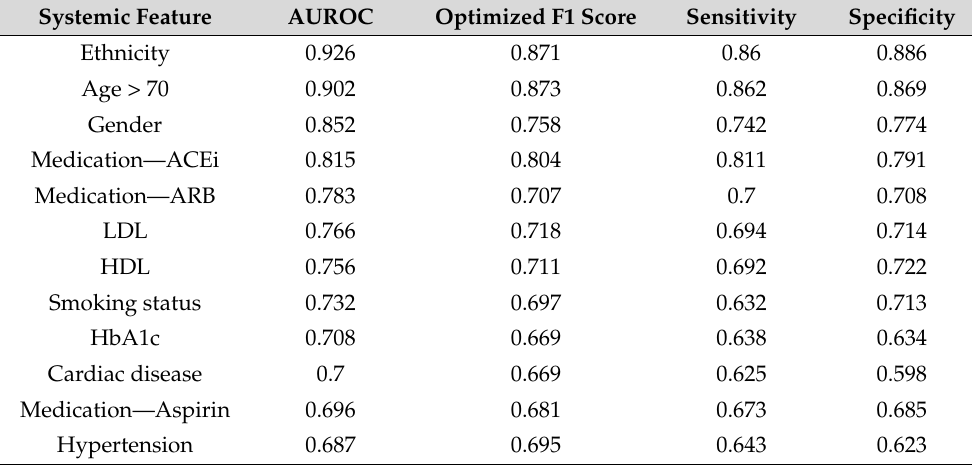
Figure 4. Five systemic features for which the ImageNet pretrained AI model achieved the highest classification accuracy based on AUROC. Dark blue represents the ImageNet pretrained model; light blue represents the retinal image pretrained model. Table 2. ImageNet-pretrained AI model performance. Achieved area under the receiver operating characteristic curve (AUROC), optimized F1 score, sensitivity, and specificity are listed. Systemic features are ordered by descending AUROC.